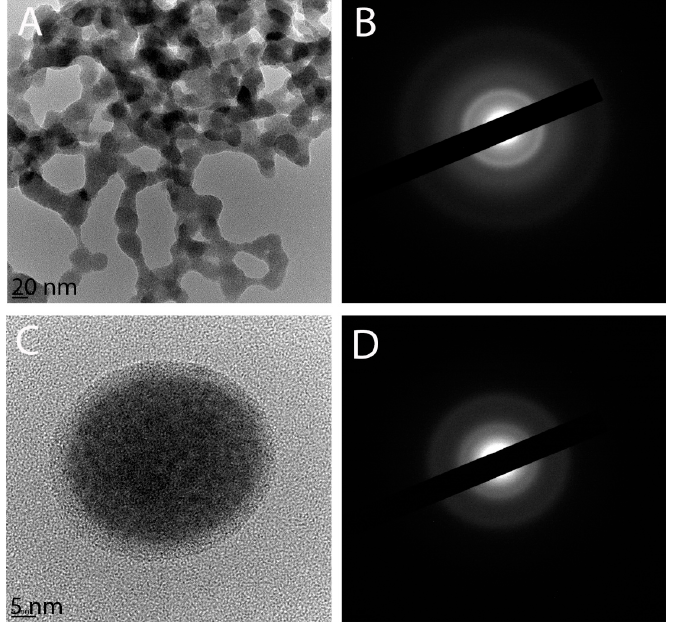
Figure 1. TEM images of aloe vera-mediated tellurium nanoparticles (AV-TeNPs): agglomerates ( A ), a single spherical Te-based nanostructure (HRTEM) ( C ), and their corresponding diffraction patterns ( B , D for A , C , respectively).